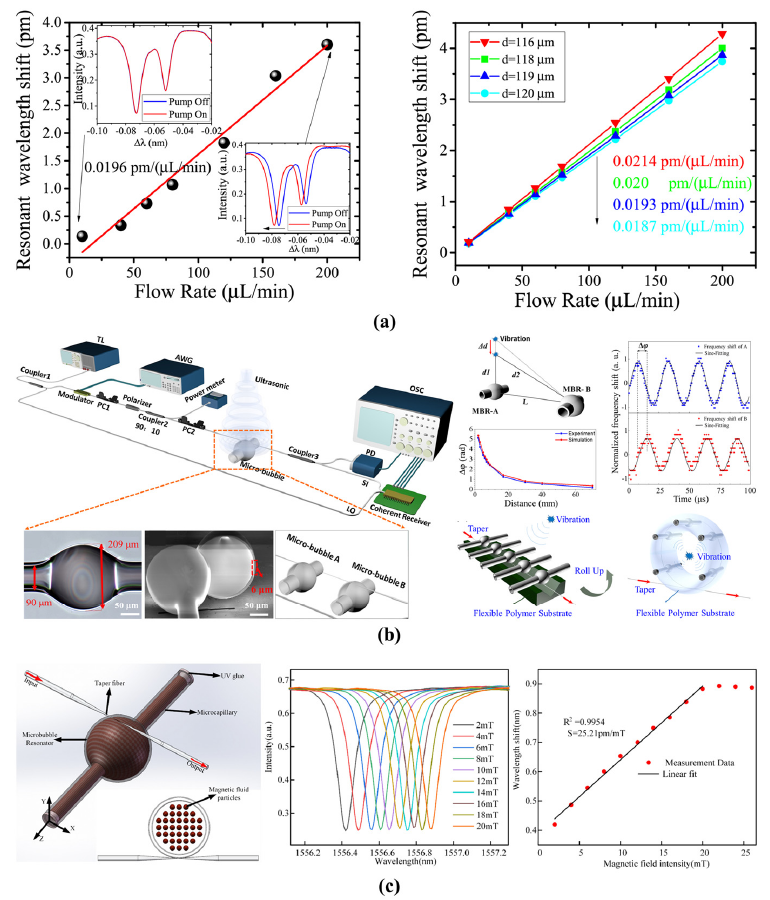
Figure 10. ( a ) A packaged microbubble resonator for flow rate sensing (reprinted with permission from [100] © Optica, formerly the Optical Society of America); ( b ) ultrasound sensing of a